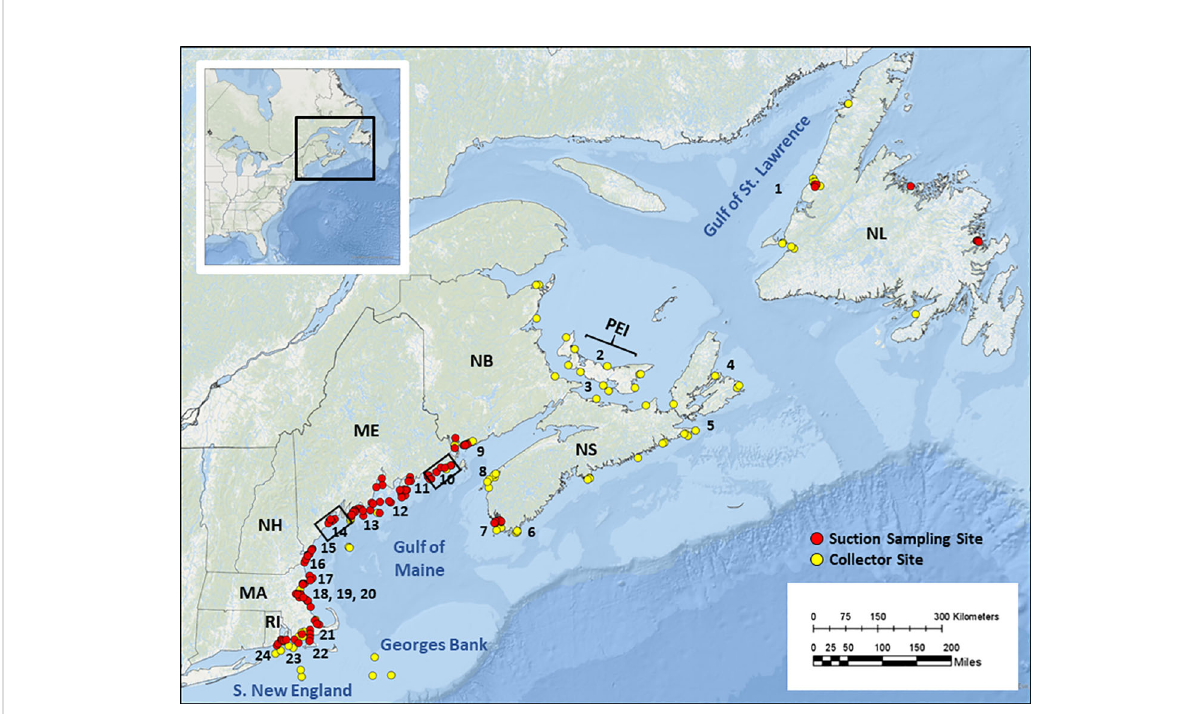
FIGURE 1 ALSI sampling sites in New England and Atlantic Canada using diver-based suction (red) and vessel-deployed collector (yellow) sampling locations. Inset map indicates coverage within eastern North America. Numbers correspond to study area descriptions and data presented in Supplement S2 and Figure 2. Abbreviations represent relevant geographic jurisdictions: Newfoundland (NL), Prince Edward Island (PEI), Nova Scotia (NS), New Brunswick (NB), Maine (ME), New Hampshire (NH), Massachusetts (MA), and Rhode Island (RI). Black rectangles denote collector deployment areas for deepwater settlement monitoring supported by Ready Seafood Co. in